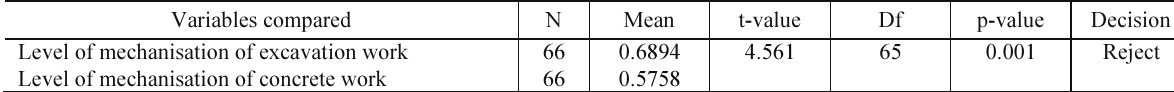
Table 5. Result of t-test for difference in level of mechanisation between excavation and concrete works Variables compared